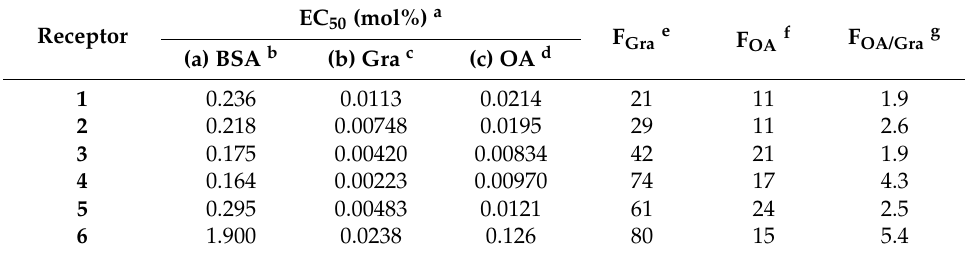
Table 2. EC 50 values shown for the NMDG-Cl assay with receptors 1 – 6 in BSA treated vesicles, in the presence of gramicidin (Gra) and in the presence of oleic acid (OA). EC 50 (mol%) Receptor